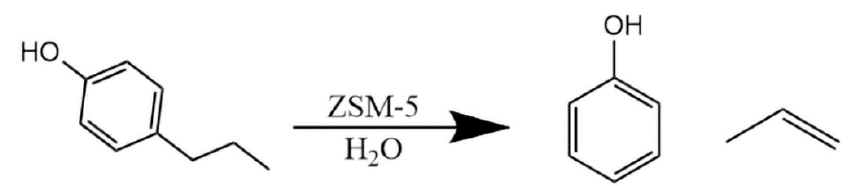
Figure 1. Reaction of 4-propylphenol to phenol and propylene over Bronsted acidic ZSM-5 zeolite in the presence of water vapor.